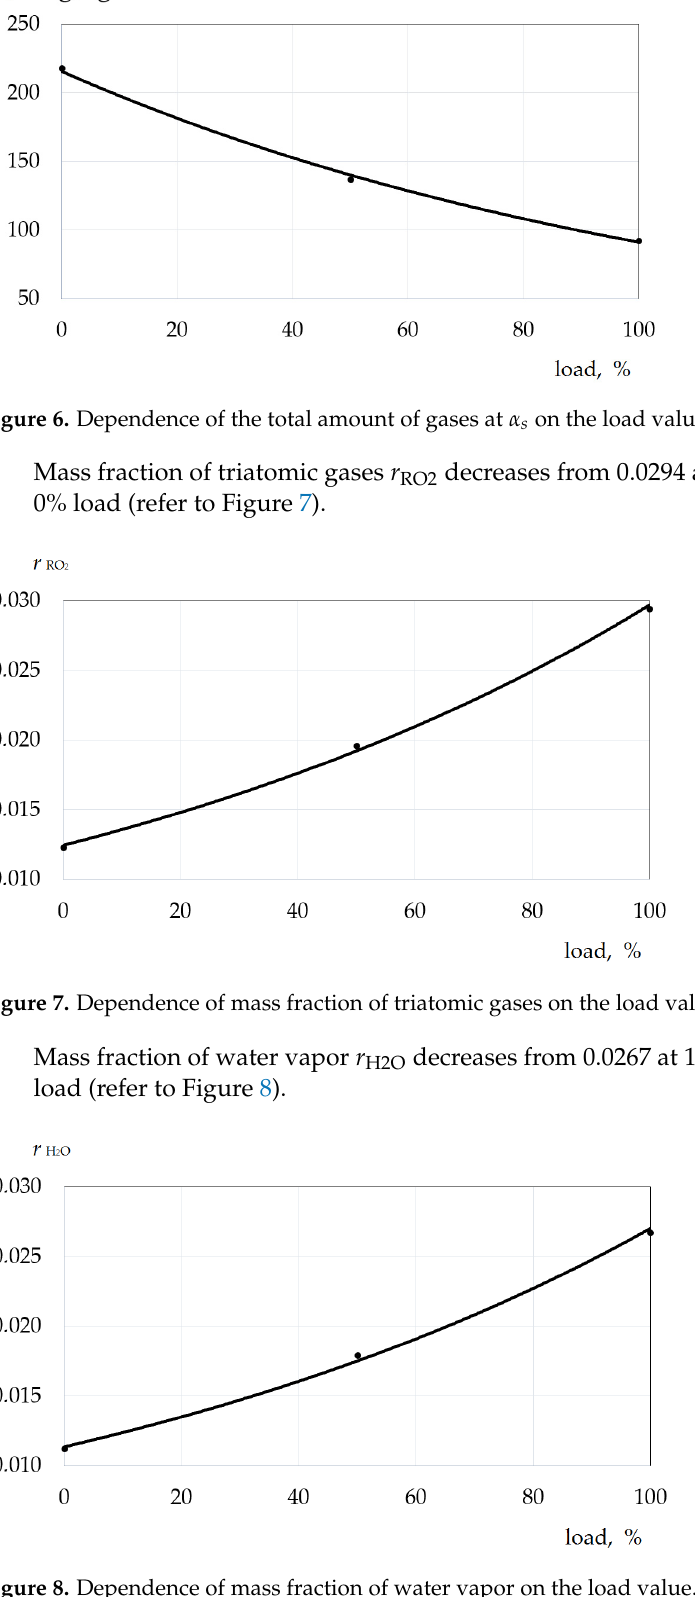
Figure 5. Dependence of air density at the combustion chamber inlet on the load value.